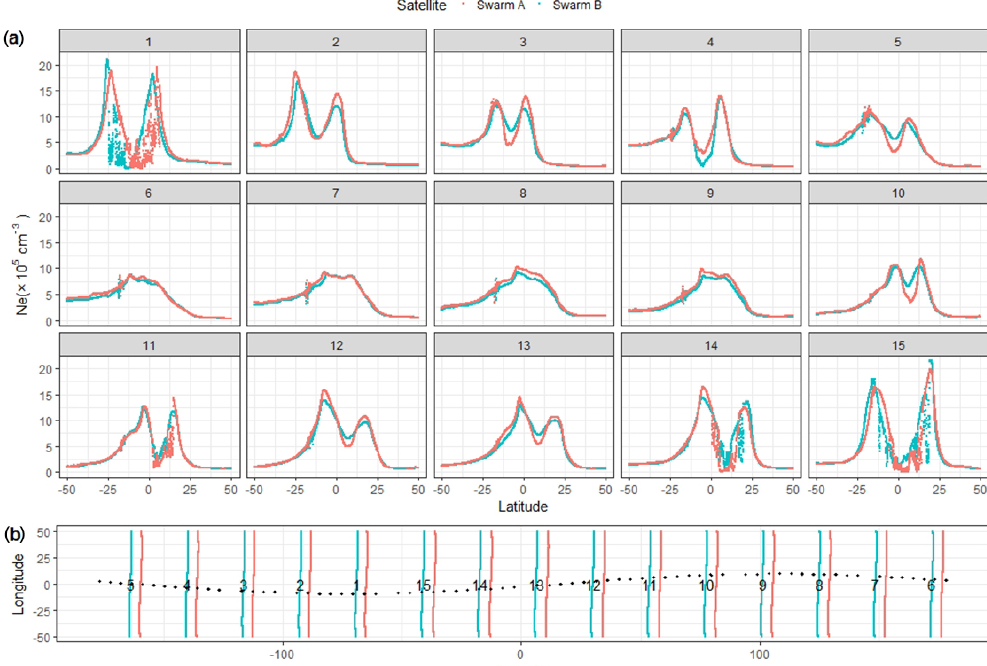
Figure 4. Morphology of nighttime stratification examples from continual orbit tracks. (a) Morphology of nighttime stratification from continual orbits on 3 February 2014. (b) Ground tracks corresponding to the continual orbit in (a) . The dotted line in (b) indicates the geomagnetic equator from dipole coordinate, and numbers on the line correspond to the numbers shown in (a)